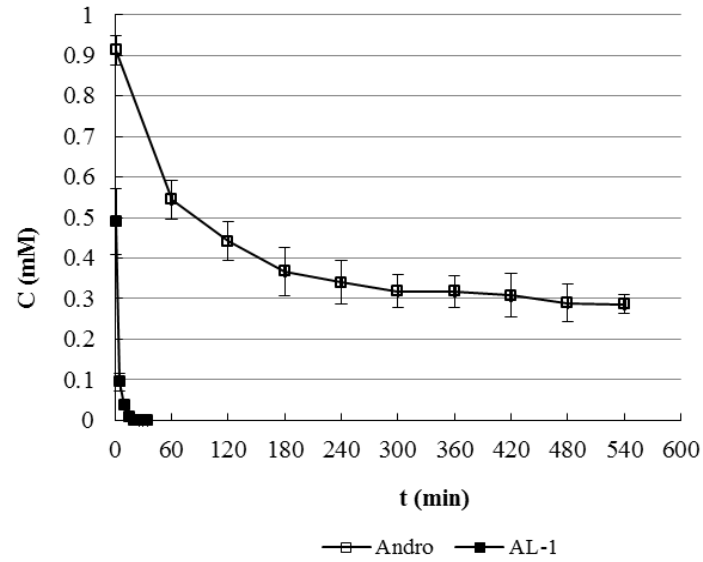
Figure 6. Change of Reactants in the Reactions of AL-1 and Andro with GSH (n = 3).